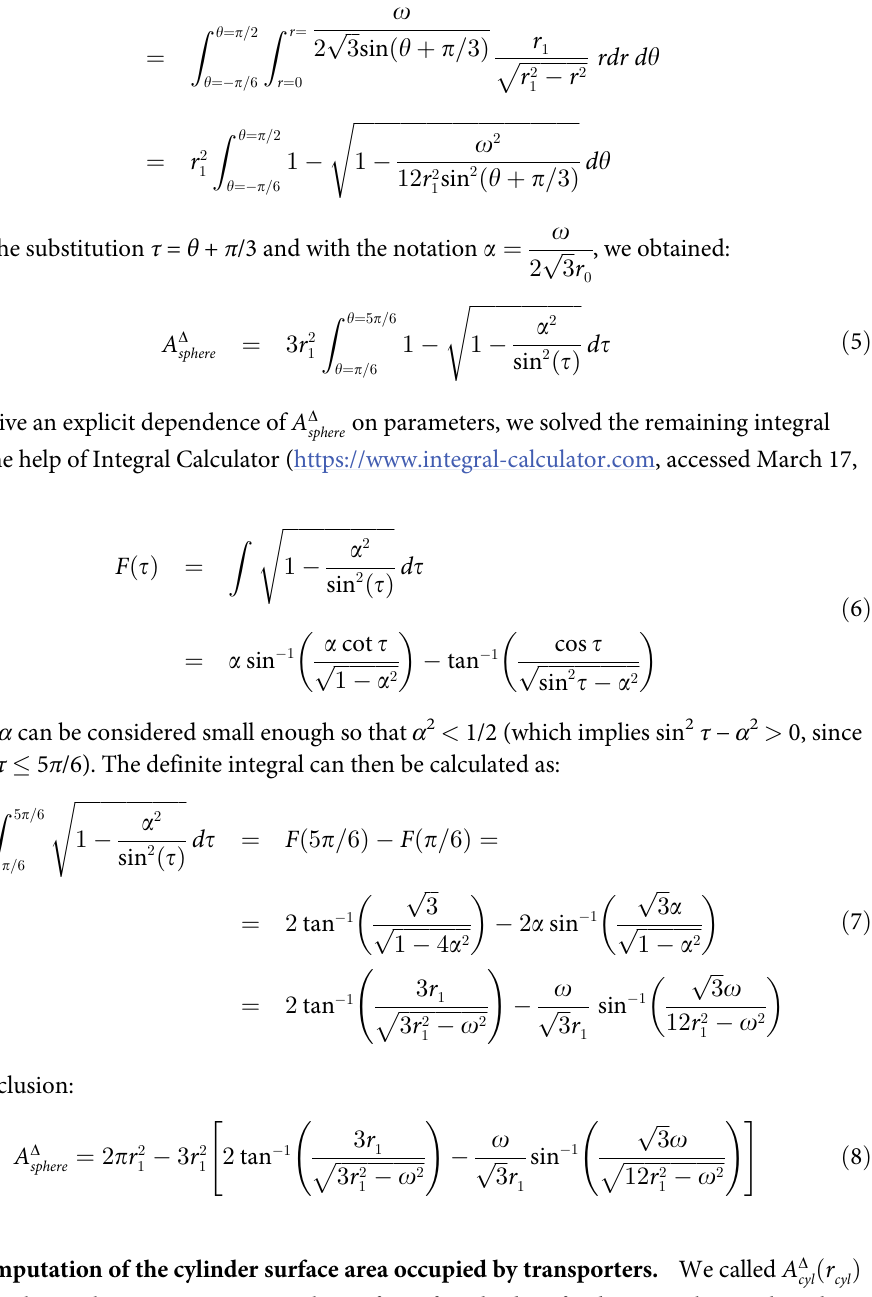
r 1 ffiffiffiffiffiffiffiffiffiffiffiffiffi